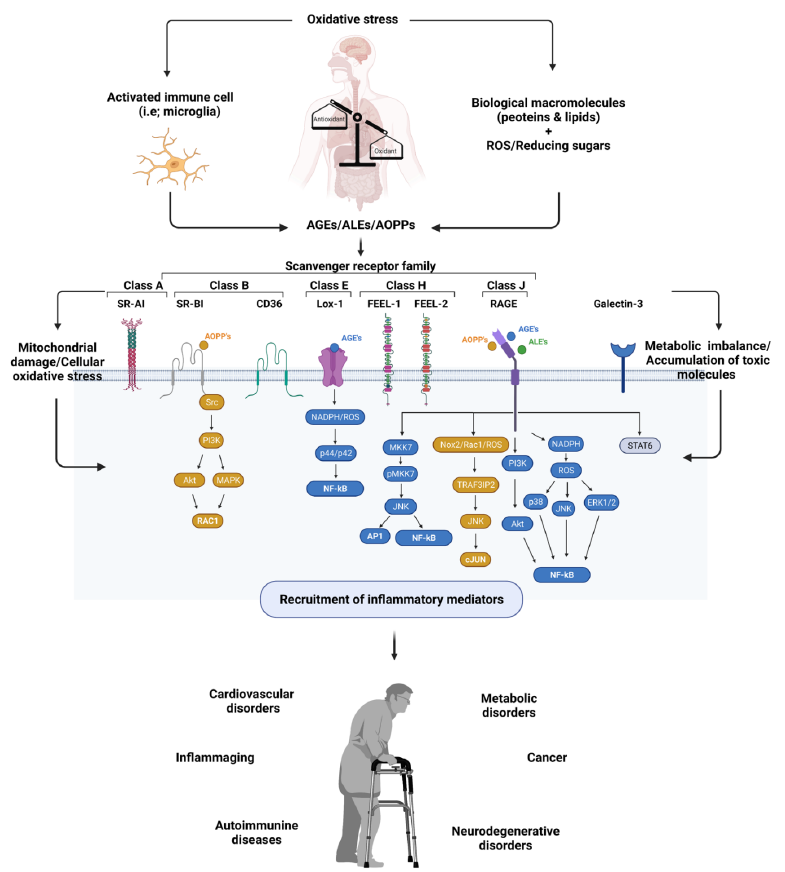
Figure 1. Exemplified figure for generation of inflammatory diseases with involvement of scavenger receptors and oxidative stress induced molecules, including AGEs, AOPPs, and ALEs; visualized using Biorender software [109].